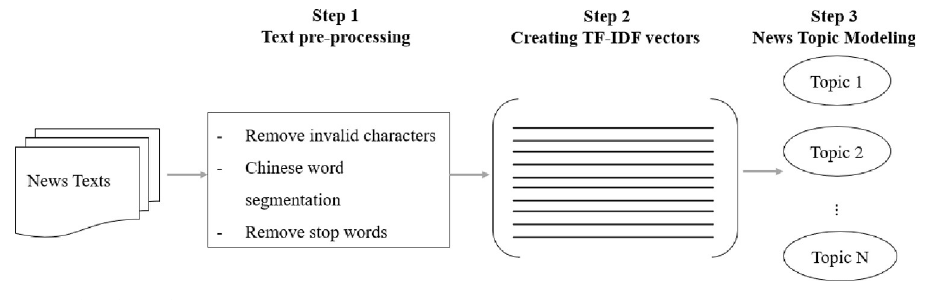
Fig 3. Flowchart of news topic